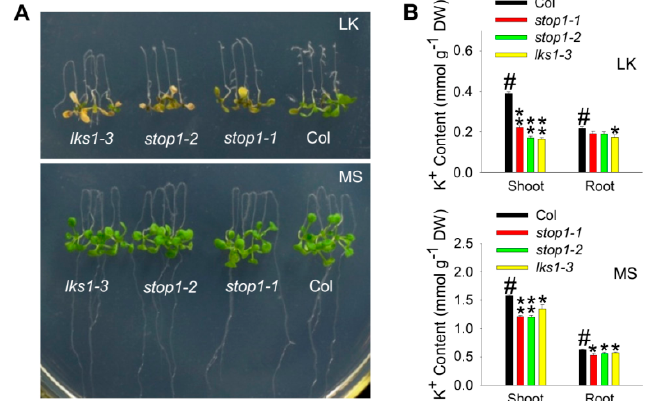
Figure 2. stop1 mutants are sensitive to low-K + stress. ( A ) Phenotype test of stop1 and lks1 mutants on MS (20 mM K + ) and LK (0.1 mM K + ) medium. Seeds were germinated on MS medium for 5 days, and then the seedlings were transferred to MS or LK medium for 10 days. ( B ) K + content measurement of indicated plants shown in ( A ) after being transferred to MS or LK medium for 7 days. Data are shown as means ± SE ( n = 4 as described in Section 4). Student’s t -test (* p < 0.05 and ** p < 0.01) was used to analyze statistical significance; # represents the control.